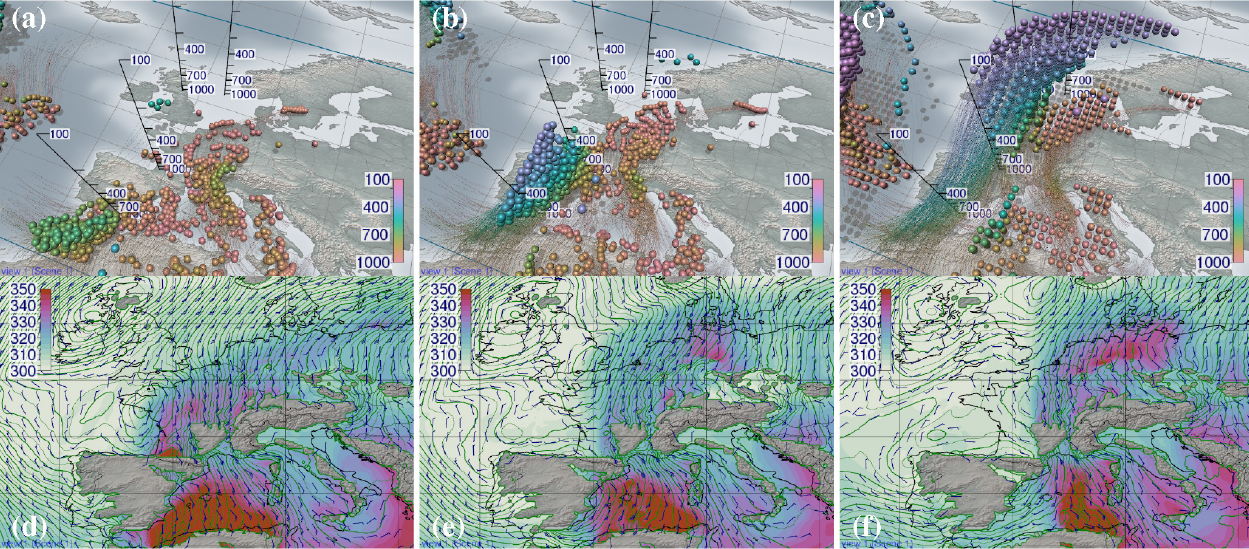
Figure 15. (a–c) Particle positions of the (backward) WCB trajectories of the ensemble control forecast, started at 18:00UTC, 19 Octo- ber 2012 and computed on the forecast initialized at 00:00UTC, 15 October 2012. Colour codes pressure elevation in hPa. (d–f) Horizontal sections of geopotential height (contour lines), wind barbs and equivalent potential temperature (colour coded in K) of the deterministic forecast from 00:00UTC, 15 October 2012 at 950hPa. Forecasts are valid at (a, d) 18:00UTC 18 October 2012, (b, e) 06:00UTC, 19 October 2012 and (c, f) 18:00UTC, 19 October 2012.